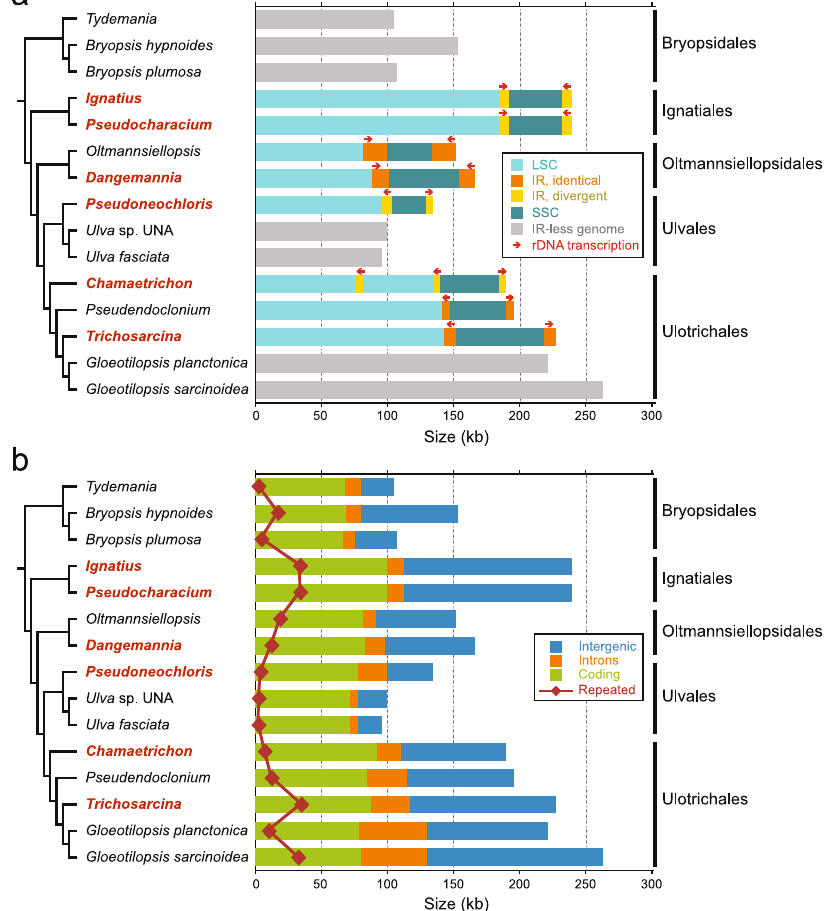
Figure 1. Sequence coverages in the 15 ulvophycean chloroplast genomes compared in this study. ( a ) Sizes of the SSC, IR and LSC regions. Red arrows indicate the direction of transcription of the rRNA operon in IR-containing genomes. Genomes lacking the IR are represented in grey. The names of the newly examined taxa are indicated in red. ( b ) Amounts of coding, intronic, intergenic and small repeated sequences ( ≥ 30 bp). Note that intron-encoded genes were not considered as coding sequences but rather as intron sequences. The phylogenetic relationships among the taxa examined are derived from Fig.